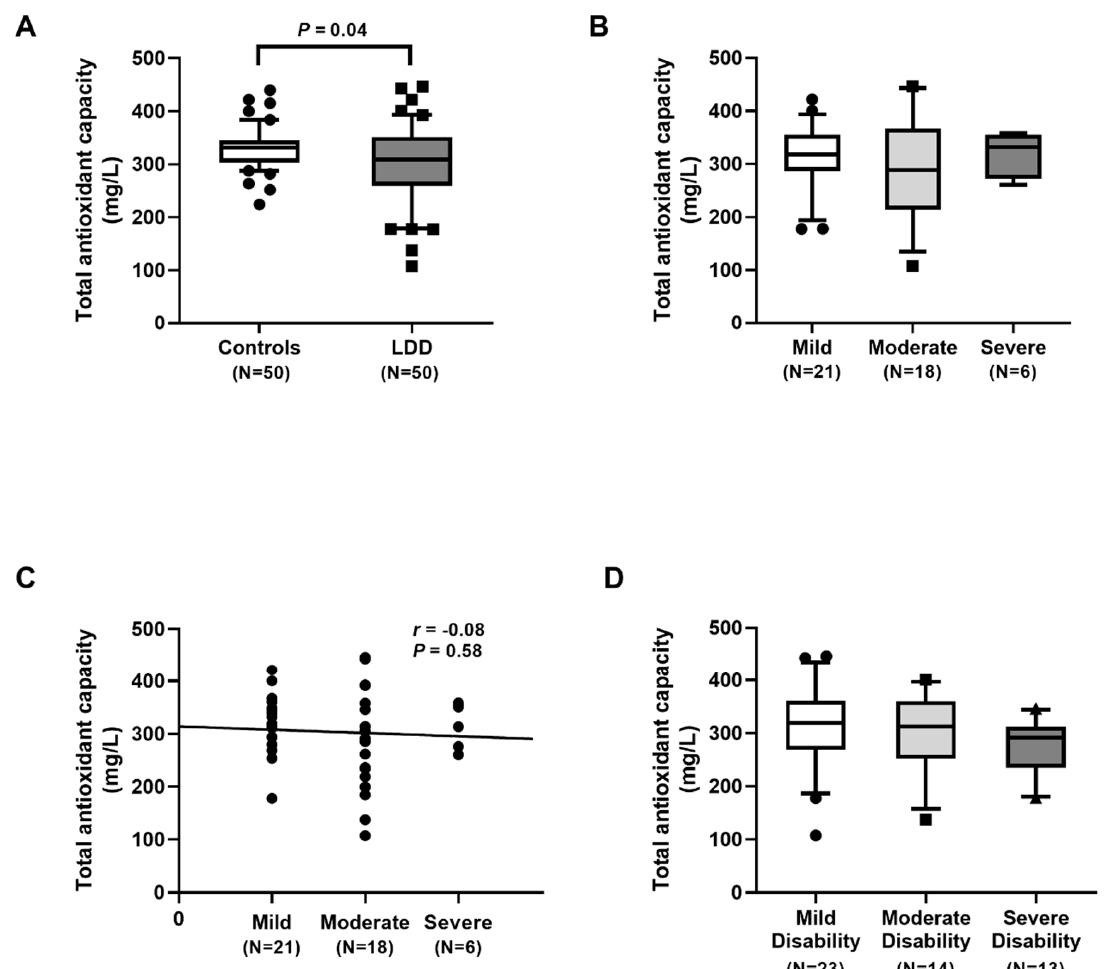
Figure 4. Determination of total antioxidant capacity (TAC): ( A ) comparison of TAC in lumbar disc degeneration (LDD) patients and controls. Circles represent control group, squares LDD group; ( B ) comparison of TAC in LDD, based on the radiographic severity. Circles represent mild group, squares moderate group; ( C ) correlation of TAC and the radiographic severity. Circles represent individual data points; ( D ) comparison of TAC in LDD, stratified by Oswestry disability index score. Circles represent mild group, squares moderate group, triangles severe group.